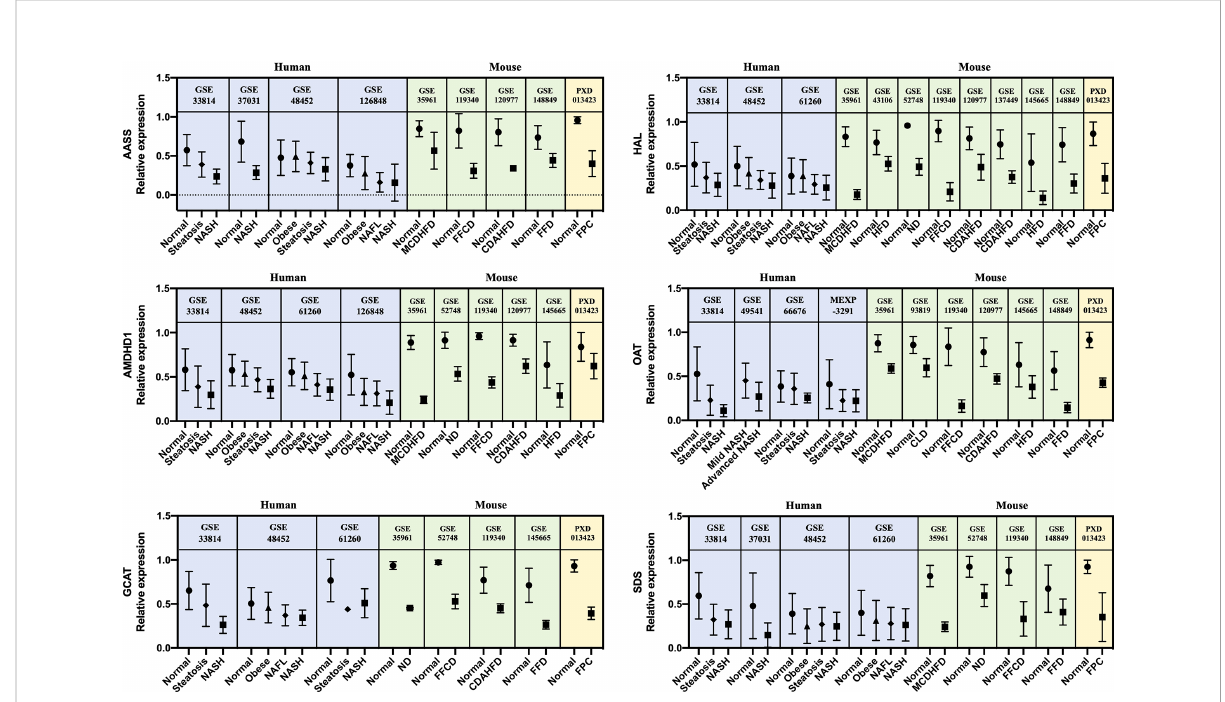
FIGURE 5 Relative gene and protein expression values of down-regulated amino acid metabolism enzymes across human and mouse datasets. Blue boxes indicate data from human transcriptome studies, green boxes indicate data from mouse transcriptome studies, and yellow boxes indicate data from mouse proteome studies. Graphs show the mean values with SD. For every dataset, p -value< 0.05 for normal versus NASH group. AASS, alpha-aminoadipic semialdehyde synthase; AMDHD1, amidohydrolase domain containing 1; GCAT, glycine C-acetyltransferase; HAL, histidine ammonia-lyase; OAT, ornithine aminotransferase; SDS, serine dehydratase.